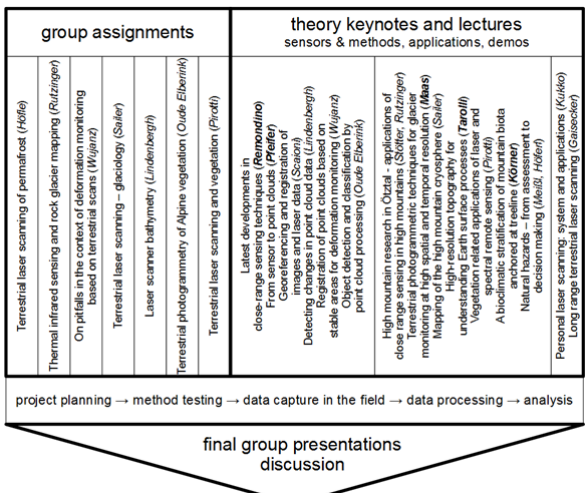
Figure 3. Concept and main content of the summer